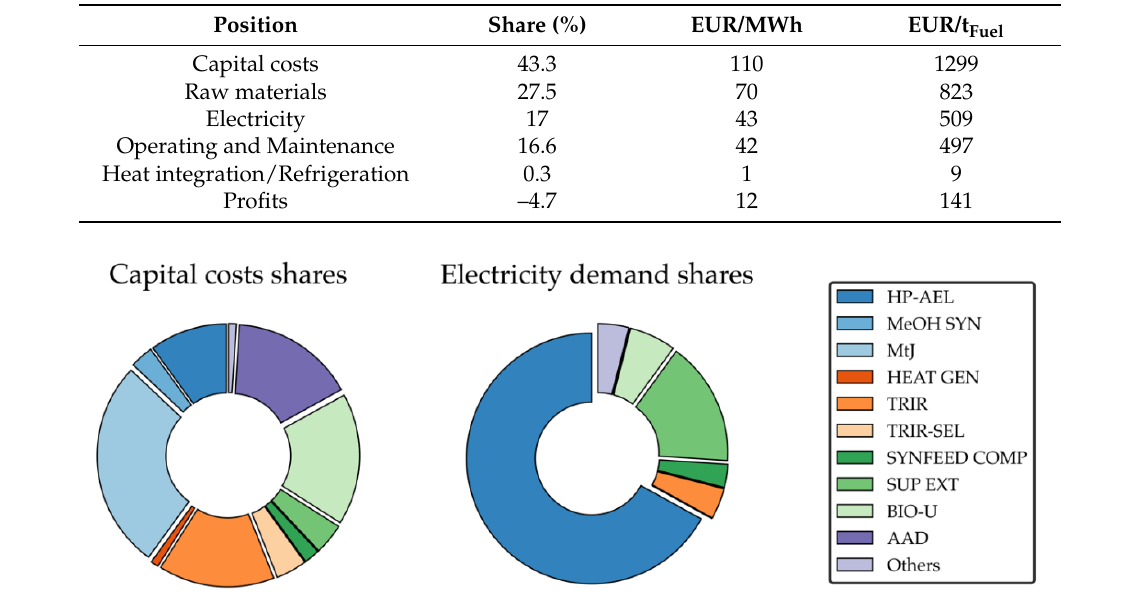
Table 9. Net production cost distribution of fuel mixtures in base case optimization.